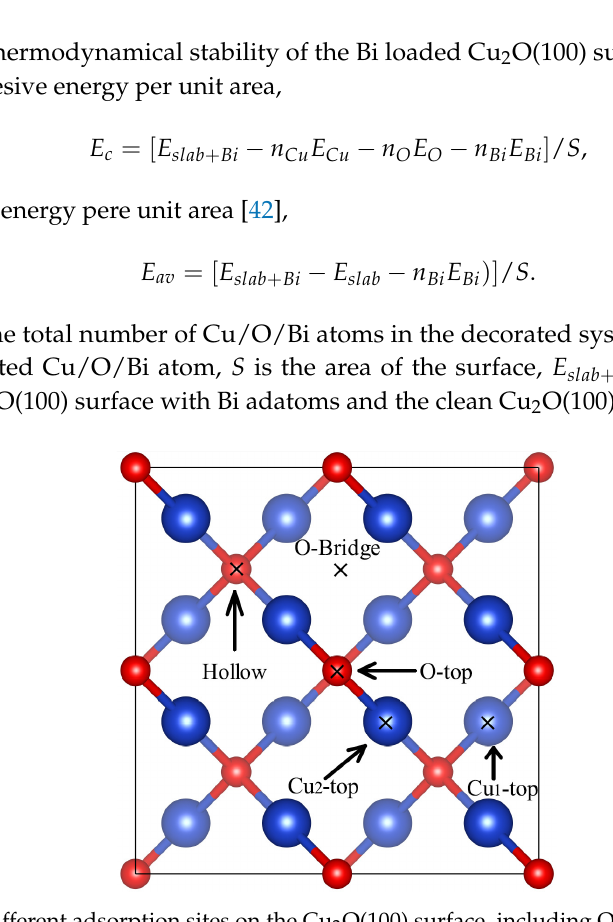
Figure 3. Five different adsorption sites on the Cu 2 O(100) surface, including O-top, O-bridge, hollow, Cu 1 -top, Cu 2 -top. The red and blue spheres represent oxygen atoms and copper atoms,